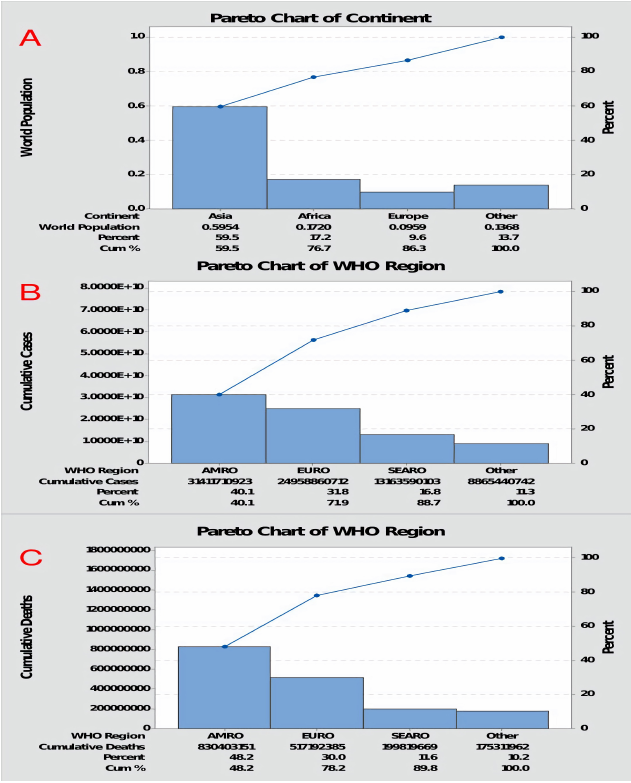
Figure 1. Pareto chart showing major continents in population census (A) and WHO main contributors in morbidities (B) and mortalities (C).